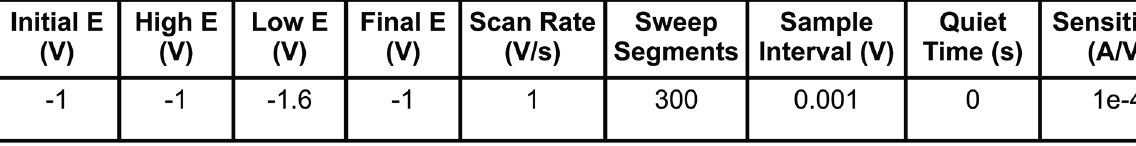
Table 1. Cyclic Voltammetry parameters for electrochemically cleaning the electrodes in 0.5 M NaOH.